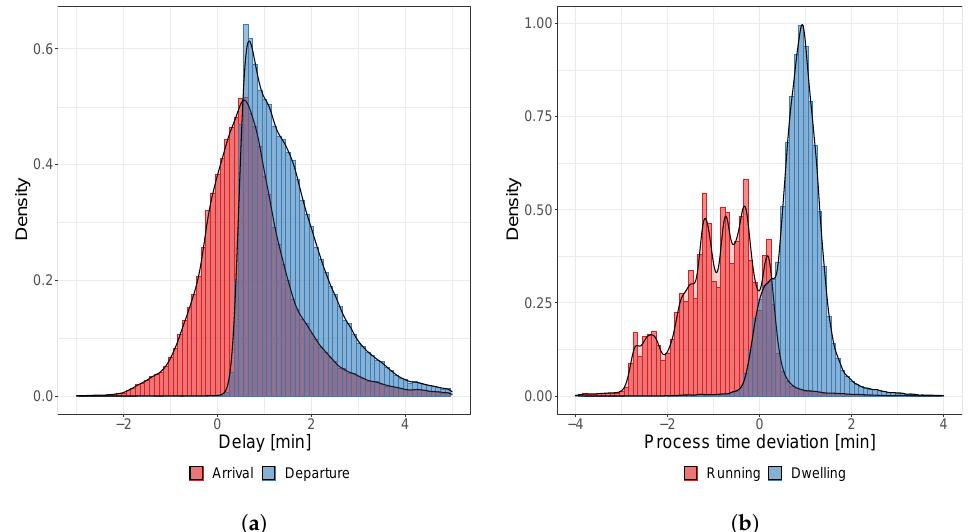
Figure 4. Histograms and empirical density estimations for delays and process time deviations. ( a ) Delay as the underlying variable of the MC-E model. ( b ) Process time deviation as the underlying variable of the MC-P model. Table 2. Calibrated state boundaries [min] for the MC-E and MC-P models (i.e., based on delays at events or process time deviations of processes) with classic and static state space structures and five states of